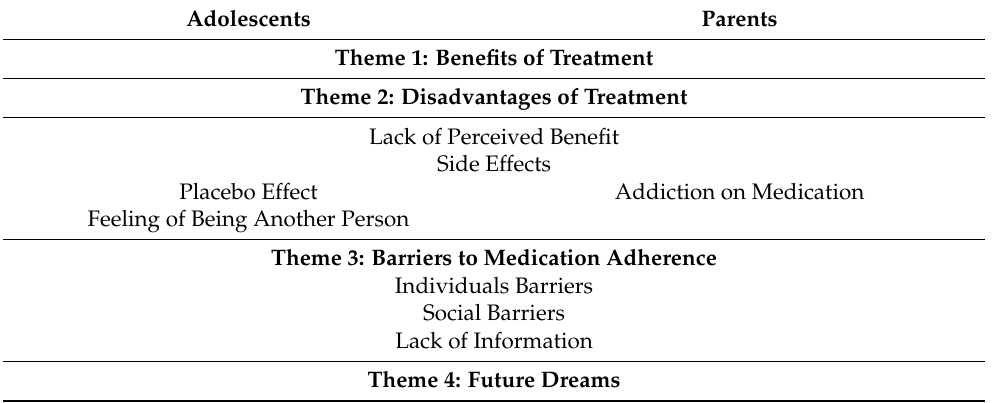
Table 3. Themes of the adolescents and their